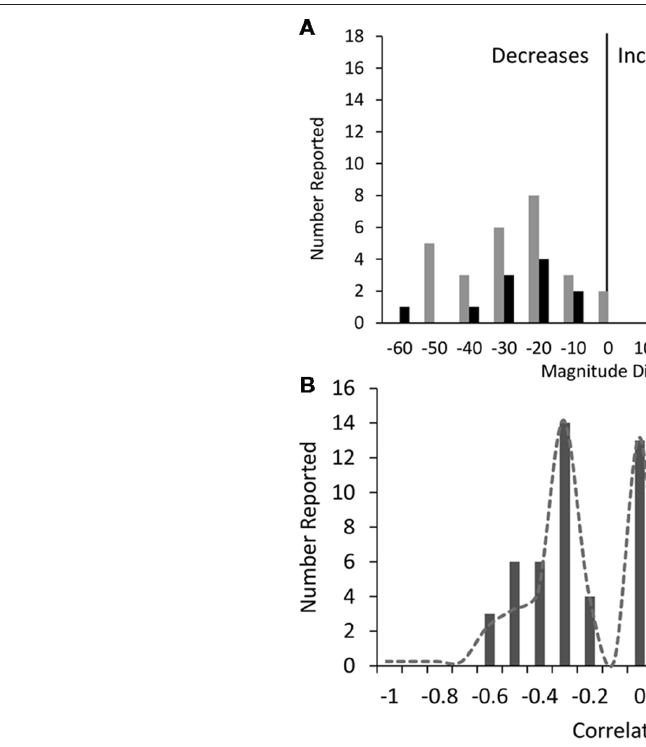
FIGURE 6 | Histograms of magnitudes of differences and correlations. (A) All reported magnitudes for differences between disorder groups and controls across all bands for absolute (gray bars) and relative power (black bars). Increases are shown as positive and decreases are negative. Reported increases for absolute power outnumbered reported decreases, although were similar in magnitude (35% and 34% respectively). Relative power was relatively symmetric with average magnitude increases of 22% and decreases of 31%. (B) Histogram of all reported correlations of band increases or decreases with symptom severity scores (all results were included even if not the dominant result). Reports of “no significant correlation” are shown as 0. Positive and negative correlations were typically between 0.2 and 0.5 although positive correlations were higher on average. High correlations ( > 0.6) were only found in two small studies ( N < 40). Dotted line shows histogram excluding these two